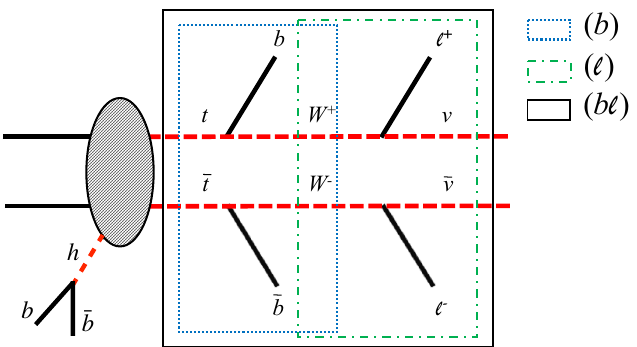
Figure 1 . The event topology considered in this paper. The blue dotted, the green dot-dashed, and the black solid boxes indicate the subsystems ( b ) , ( ‘ ) , and ( b‘ ) , respectively. define a new variable in the ( ‘ )